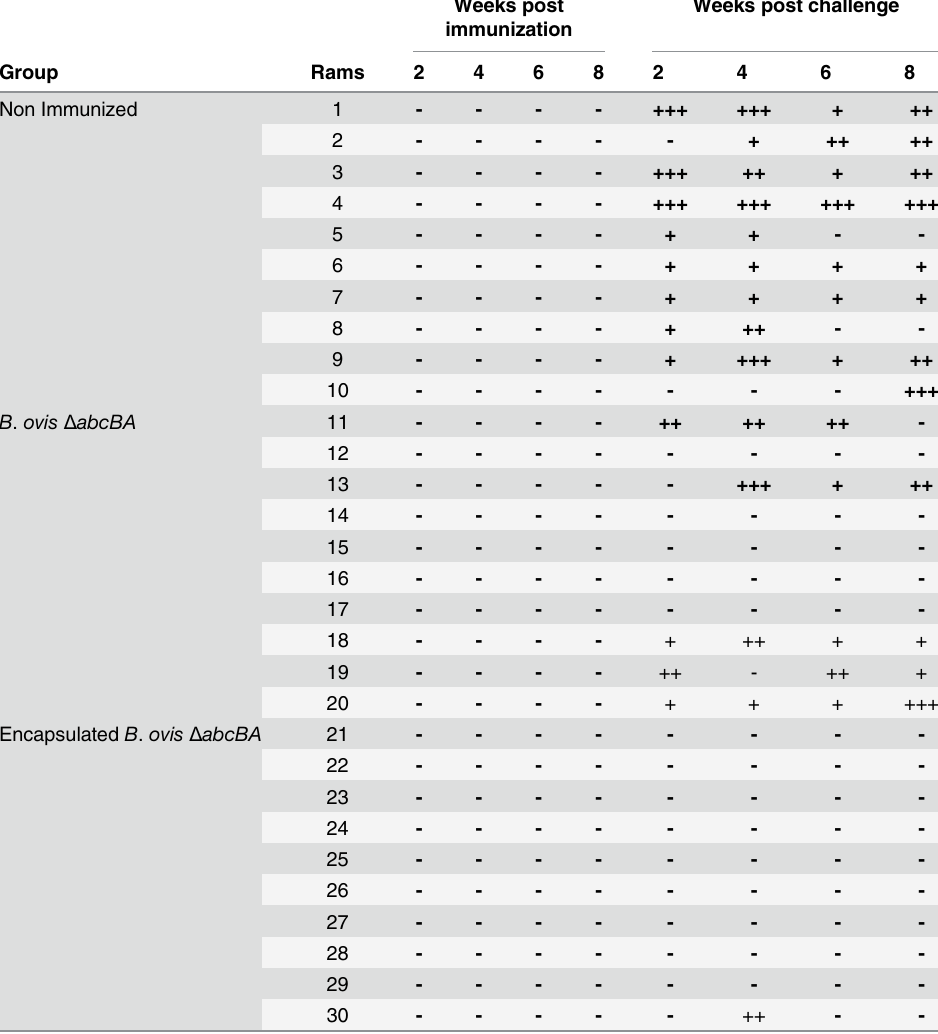
Table 1. Inflammatory cells in the semen of non immunized rams and rams immunized with encapsu- lated or non encapsulated B . ovis Δ abcBA , and challenged with wild type B . ovis . Semi-quantitative semen evaluation of inflammatory cells: ( – ) absence, (+) mild, (++) moderate, (+++)